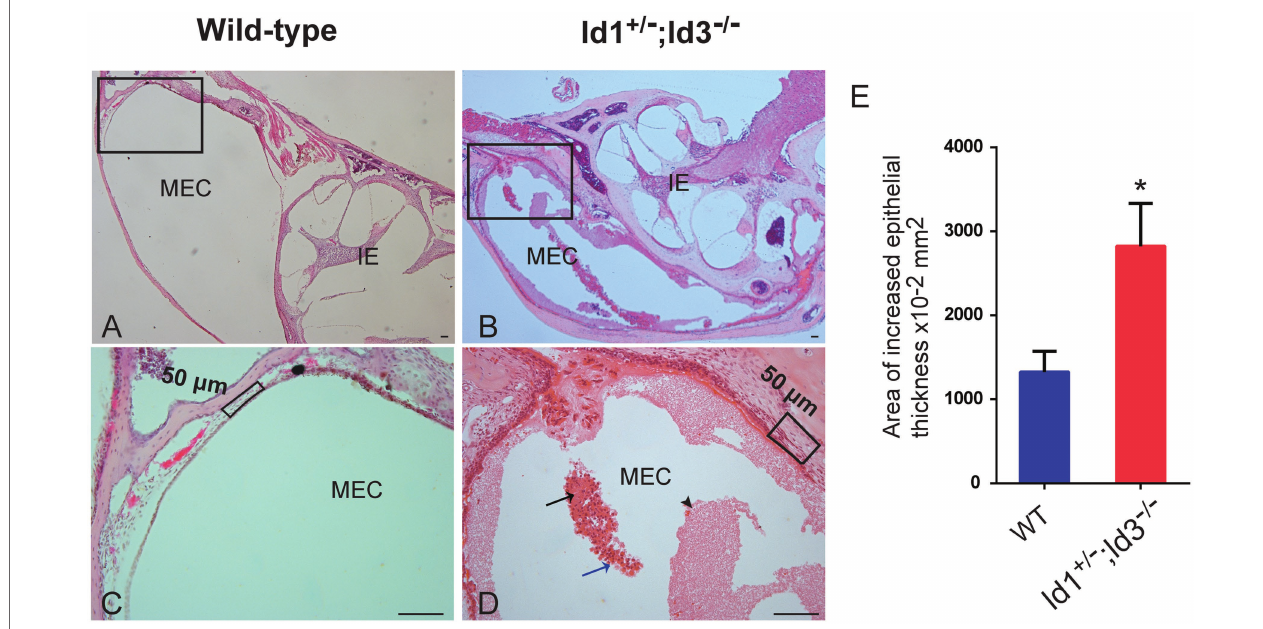
FIGURE 5 | Hematoxylin-Eosin (H&E) staining of histopathology of wild-type and Id1 +/ − ; Id3 − / − mice. (A-D) Representative histology showed obvious inflammatory infiltrations in the MEC of Id1 +/ − ; Id3 − / − mice (B,D) compared to the wild-type mice (A,C) . Scale bars: 50 μ m. (A) The MEC and inner ear (IE) were absent of inflammations. (C) The boxed region of (A) . (B) Panoramic view of the histology showed various inflammations in the MEC. (D) At higher magnification, the boxed region in (B) revealed detailed view of the cell infiltrations. Exudates of fibrin and blood plasma were evident (black arrowhead). Masses of erythrocytes (black arrow) together with neutrophils (blue arrow) were also detectable in the MEC. (E) Comparison of the area of epithelial thickness in MEC between Wild-type mice and Id1 +/ − ; Id3 − / − mice ( n = 3 mice in each group). * p <